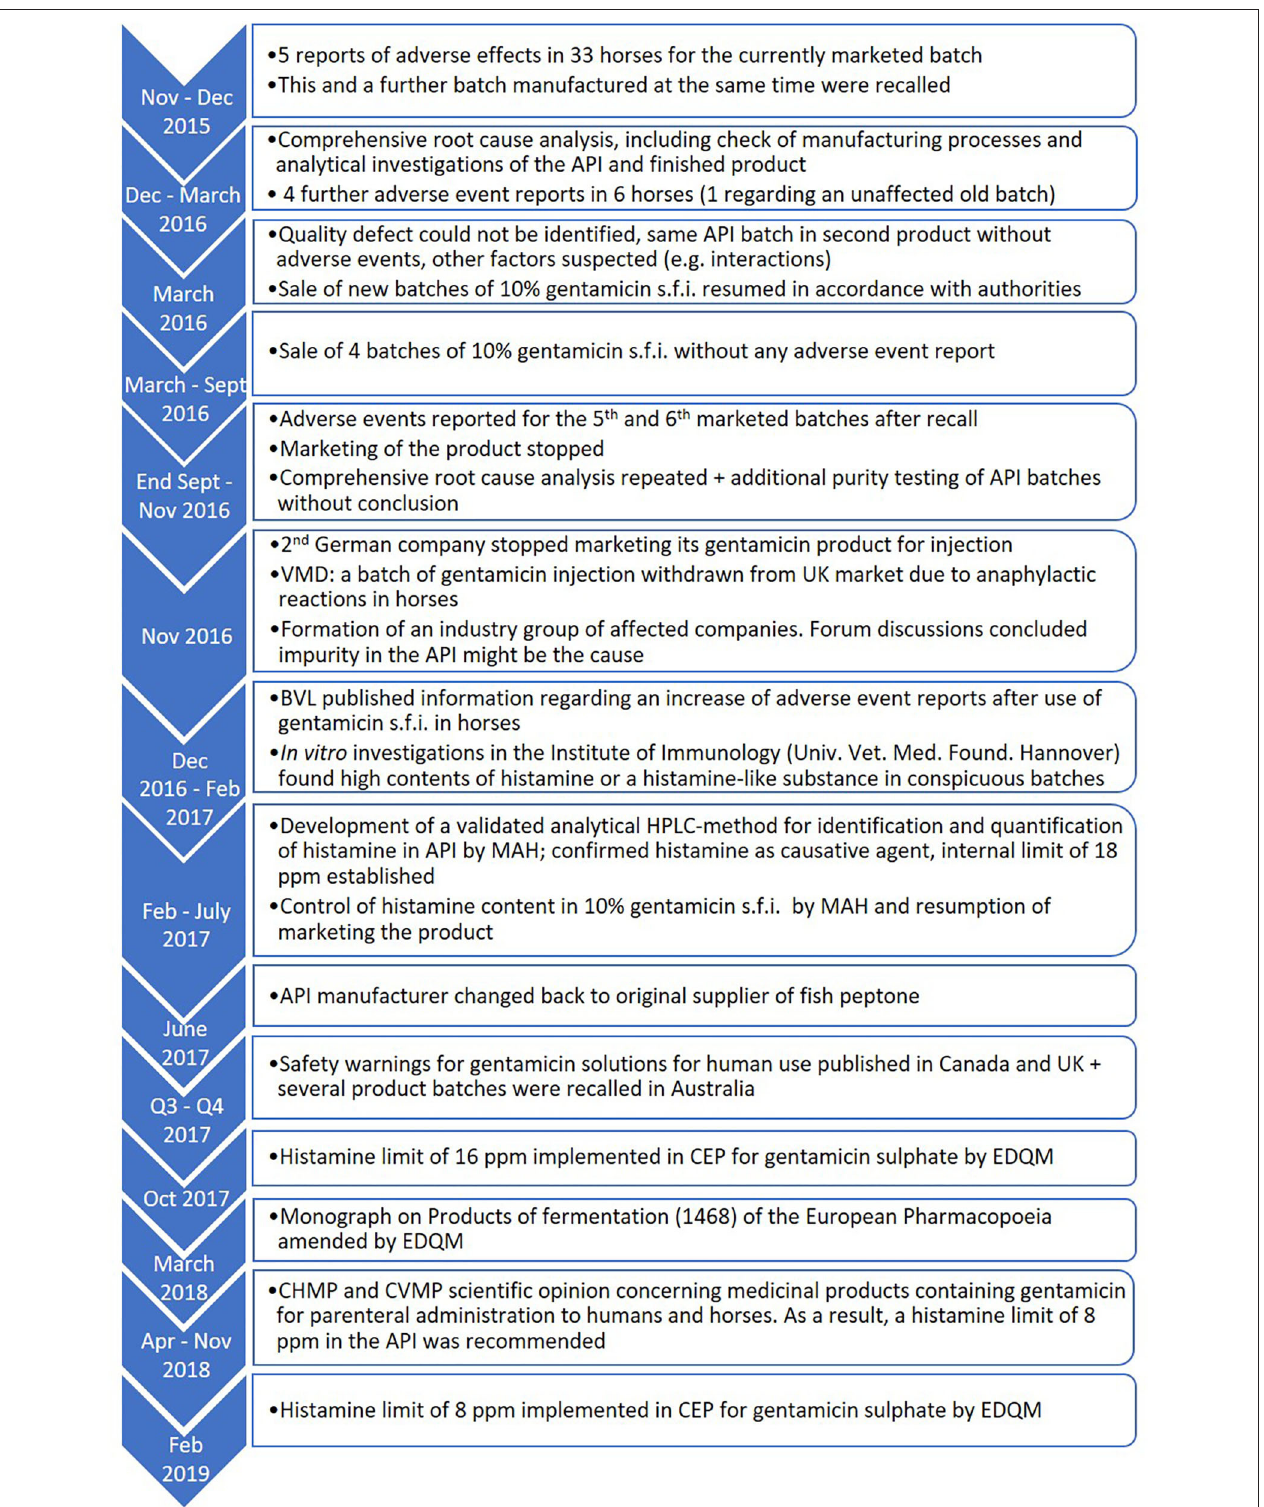
Frontiers in Veterinary Science |